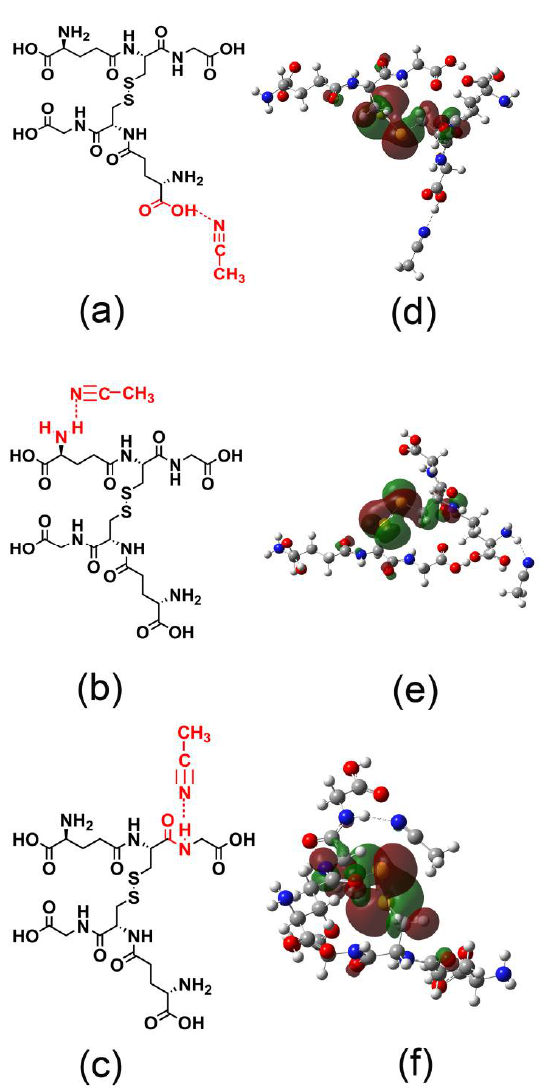
Figure 5. Hypothesized hydrogen bonds formed between acetonitrile and the GSSG functional groups: ( a ) carboxyl group, ( b ) amine group, and ( c ) amide group. ( d – f ) Corresponding frontier molecular orbitals of the charge transfers for ( a – c ). Table 2. Adsorption energies of acetonitrile on GSSG and GSH in aqueous solution (kcal/mol).